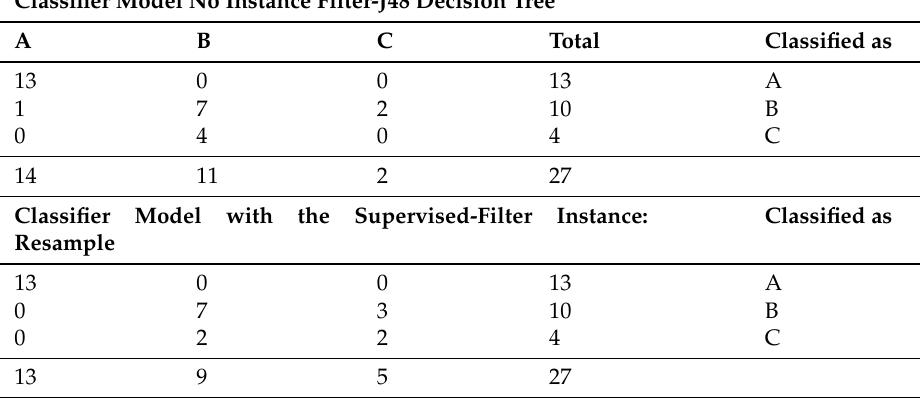
Table 6. Confusion matrix of the classification of the level of energy-environmental e ffi ciency with the J48 decision